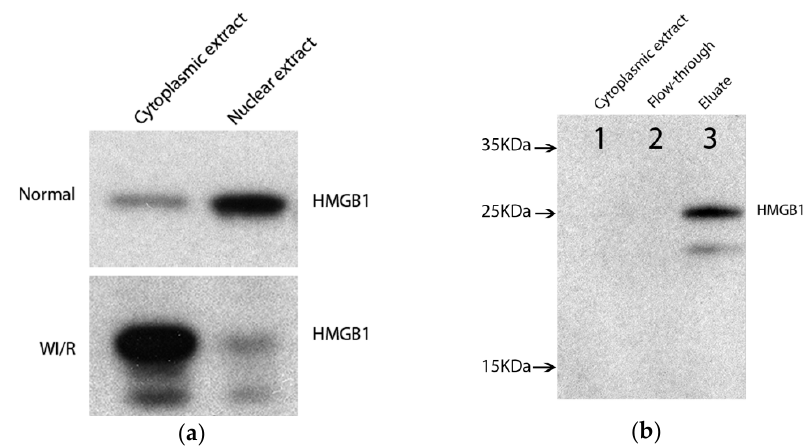
Figure 1. ( a ) Relative amount of high-mobility group box 1 (HMGB1) in cytoplasmic versus nuclear extract in warm ischemia reperfusion (WI/R) and normal liver. In normal rat liver tissue, HMGB1 level in nucleus was higher than in cytoplasm, whereas in WI/R liver tissue, HMGB1 protein was increased and higher in cytoplasm than in nucleus, suggesting translocation from nucleus into cytoplasm. Increased production as well as translocation from nucleus to cytoplasm implies that cytoplasmic HMGB1 is involved in hepatocellular response to damage caused by WI/R. Each lane contained the same protein amount (30 µg); ( b ) Enrichment of cytoplasmic HMGB1 protein from WI/R liver using co-immunoprecipitation (co-IP). HMGB1 was enriched into co-IP eluate. Considering the limited use of mild detergent in cytoplasmic protein extraction, this result allows the assumption that not only HMGB, but also the binding proteins, were enriched through the co-IP procedure. Each lane contained the same amount of protein (2 µg). We speculated that the faint band represents oxidized HMGB1, as shown previously by our group [5]. There was no signal detected in lane 1, for the loaded protein amount in cytoplasmic extract was too limited.